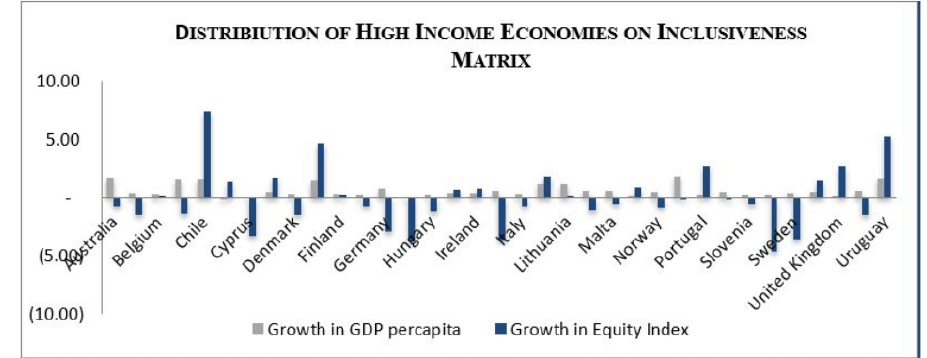
Figure A. 2: Distribution of Economies on Inclusiveness